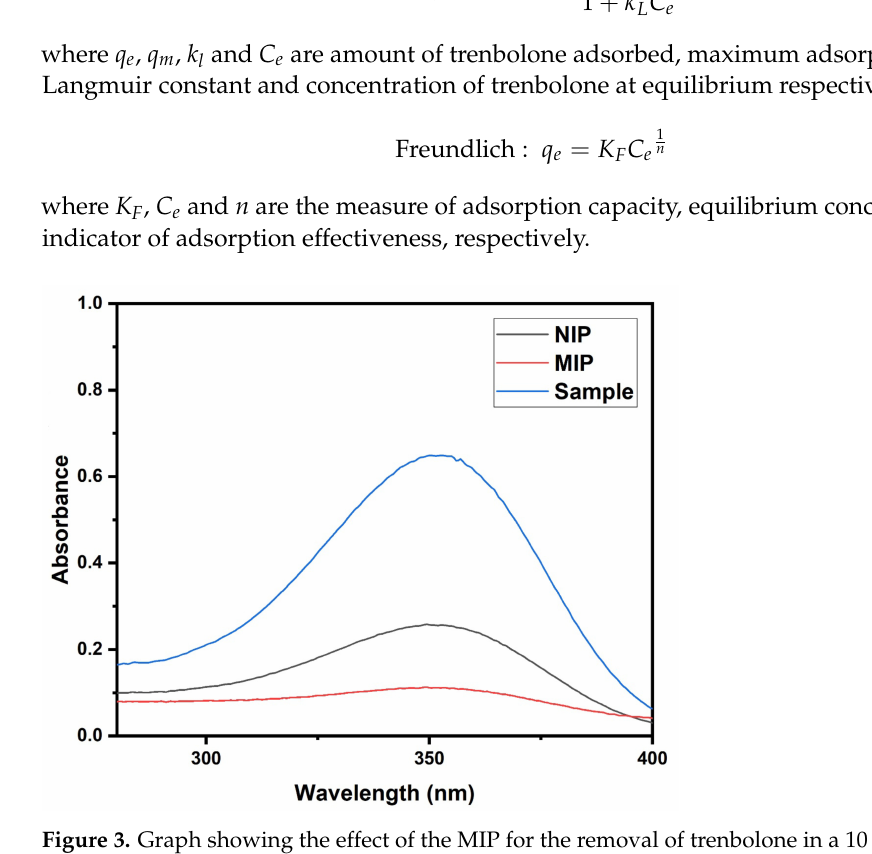
Figure 3. Graph showing the effect of the MIP for the removal of trenbolone in a 10 mg/L solution. NIP = 10 mg/L solution after adsorption onto the nonimprinted polymer, MIP = 10 mg/L solu- tion after adsorption onto the imprinted polymer and Sample = original 10 mg/L solution before adsorption.